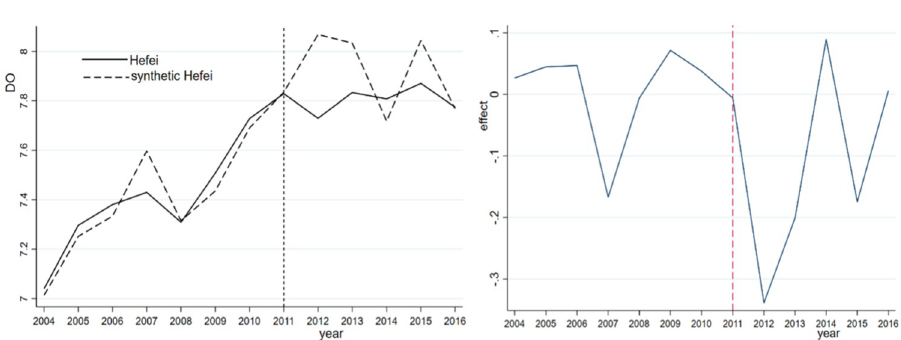
Fig 3. DO and its effect for Hefei and synthetic Hefei.